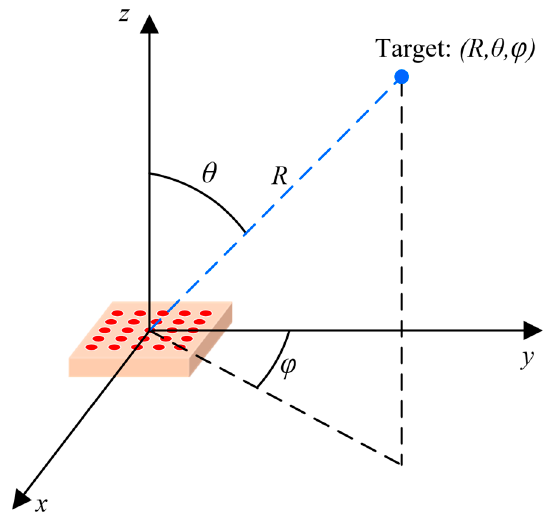
Figure 20. Illustration of a pMUT rangefinder target positioning system.